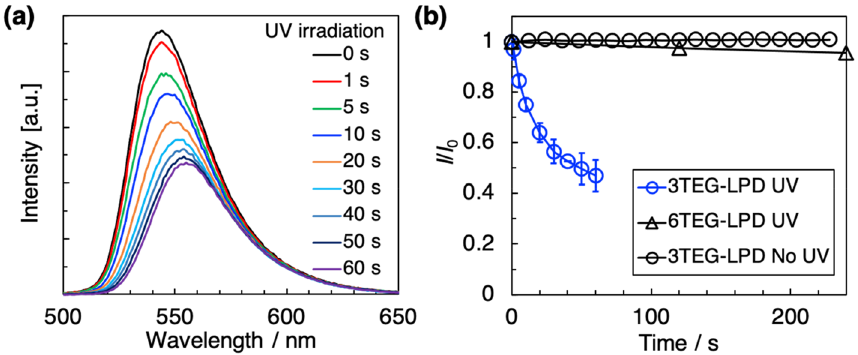
Figure 3. ( a ) Variations in fluorescence spectra of 1.0 mM calcein/5.0 mM 3TEG-LPD aqueous solution under UV irradiation. ( b ) The normalized transient changes in fluorescence intensity at the peaks for 1.0 mM calcein/5.0 mM 3TEG-LPD in the absence and presence of UV irradiation and 6TEG-LPD aqueous solutions in the presence of UV irradiation.